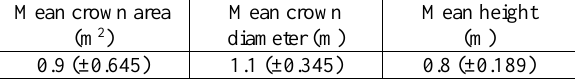
Table 1. The quantitative characterization of eshnan shrubs (n =